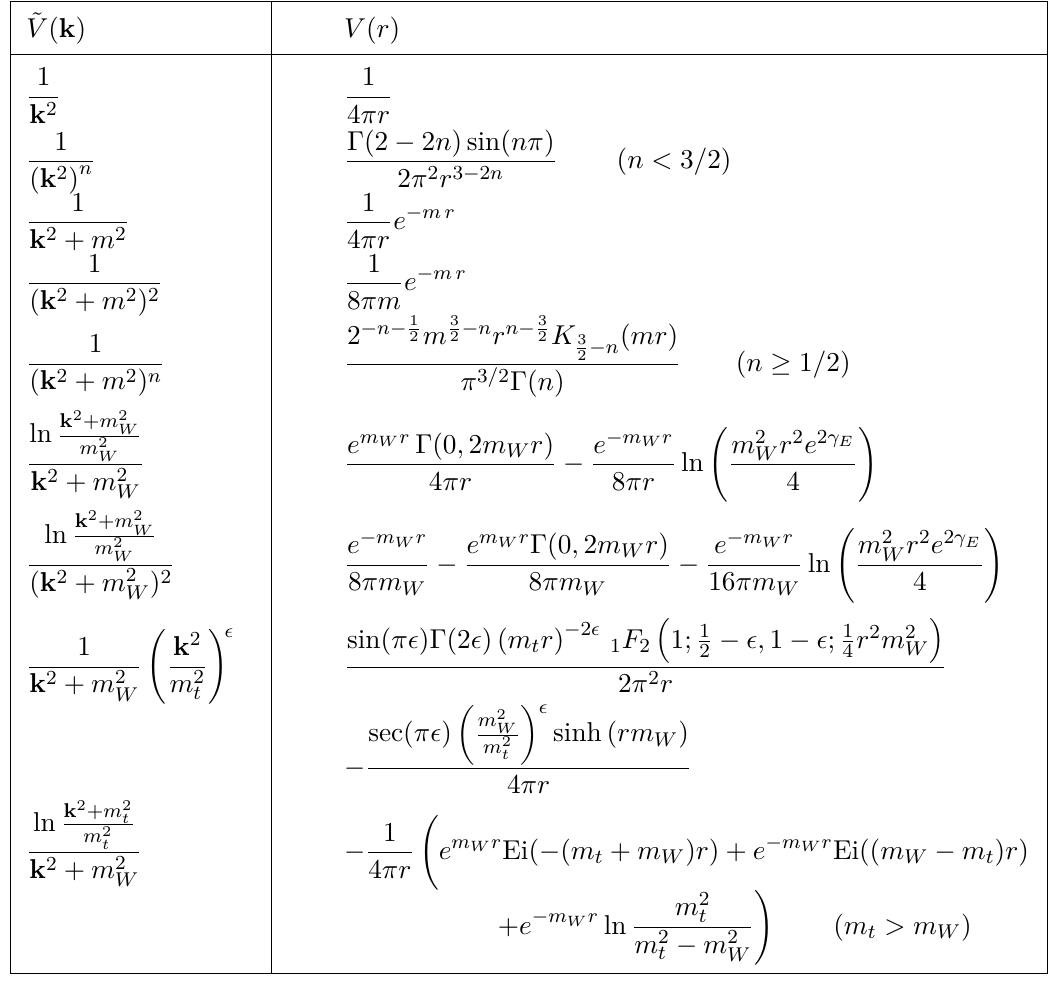
Table 1 . Table of Fourier transforms. K n denotes the modified Bessel function of the second kind, Ei the exponential integral function, n F m the generalized hypergeometric